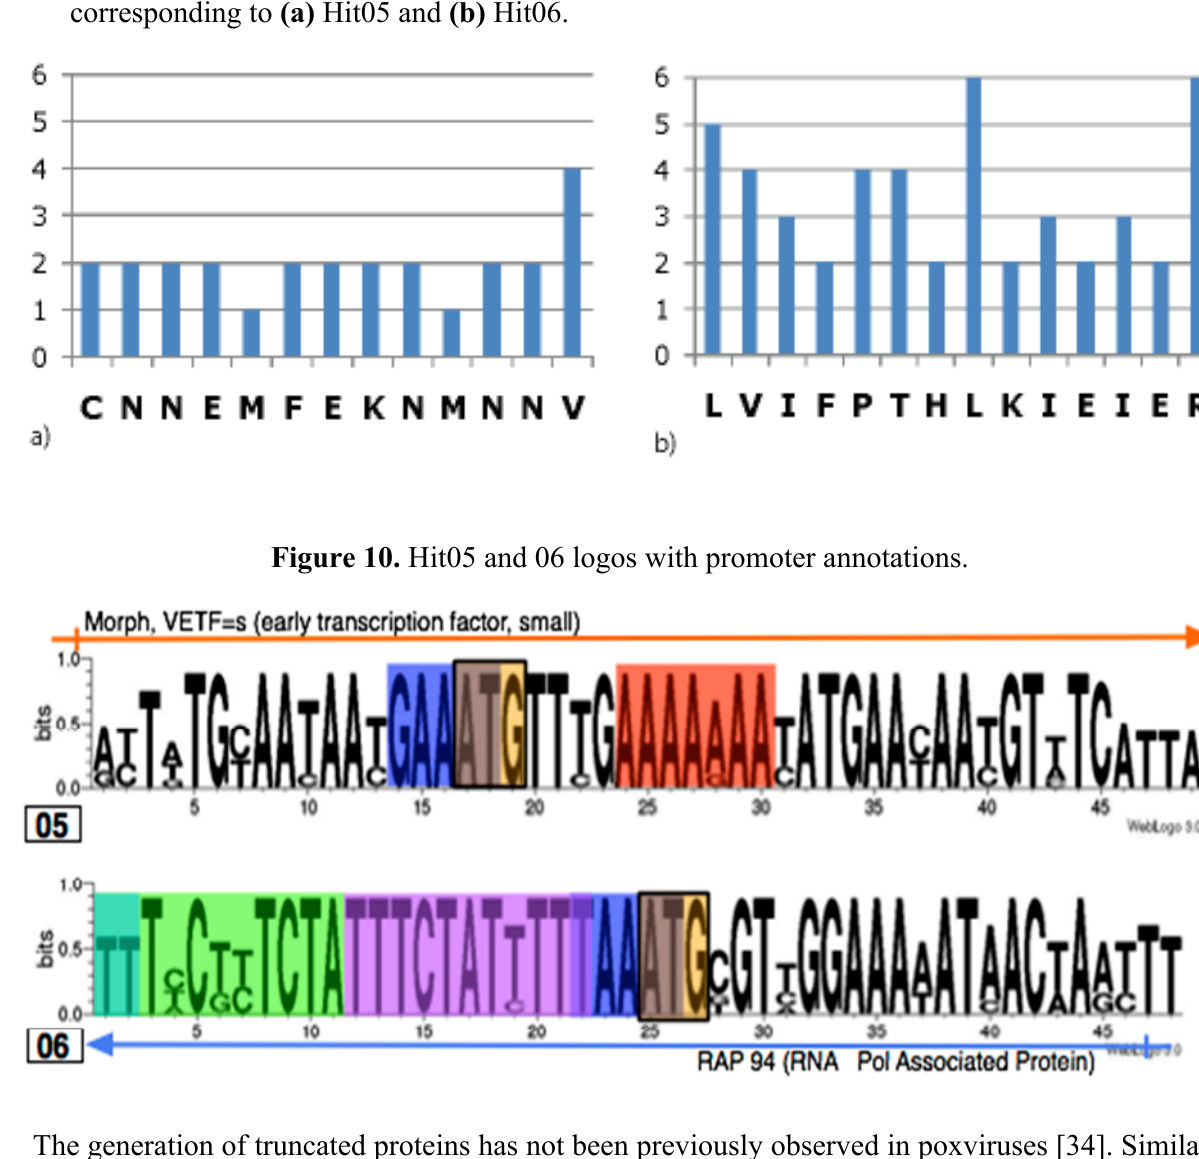
Figure 9. Histograms showing the degeneracy of each amino acid in the protein sequences corresponding to (a) Hit05 and (b) Hit06.